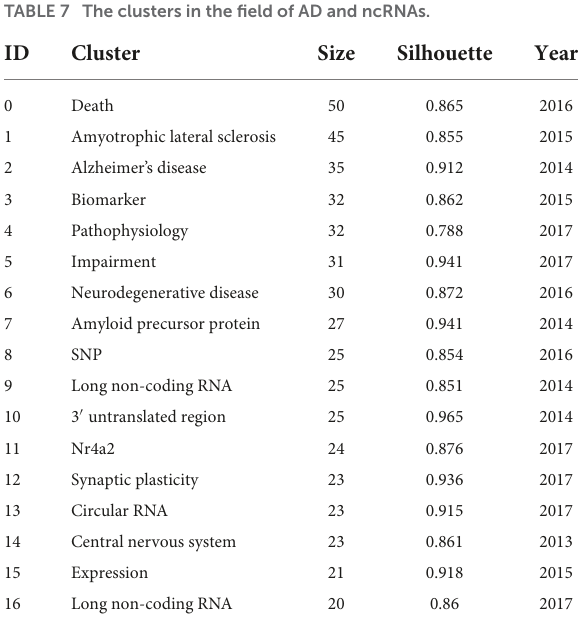
TABLE 7 The clusters in the field of AD and